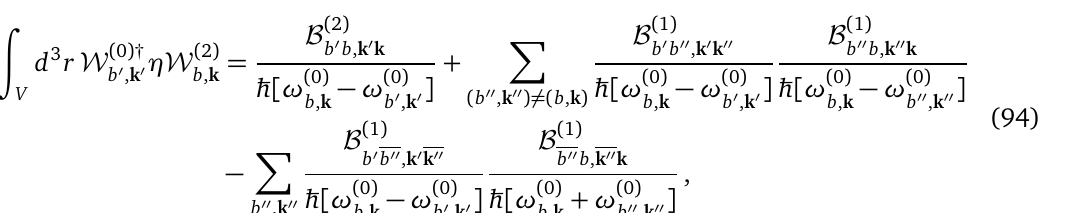
Figure 6: Lowest bands of the Bogoliubov spectrum as functions of k ħ h Ω = 0.2 E . The solid curves represent the exact values determined numerically, R R the dashed ones correspond to the perturbation estimates. Note the unphysical diver- = k gence of the latter at k ,1, k . Close to each band we write the corresponding x c 2 c 3 value of the index b . The interaction parameters are the same as Fig.